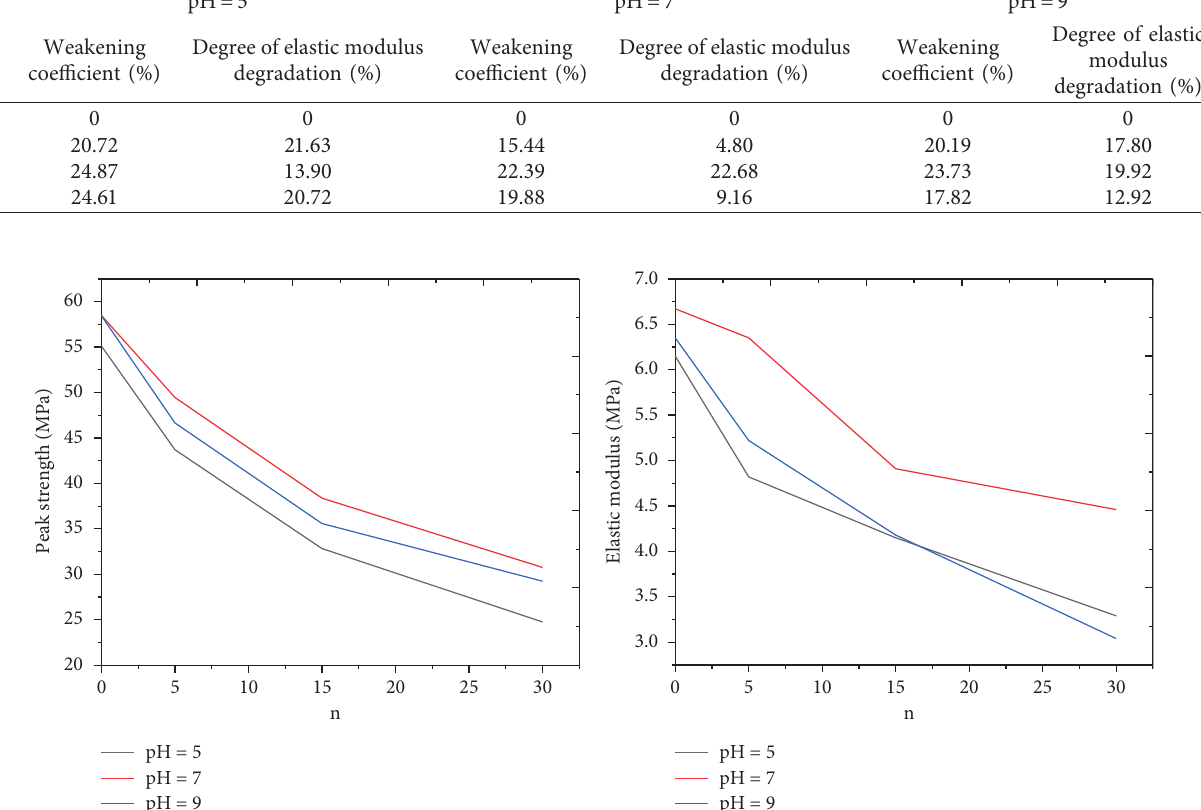
Figure 4: Change of mechanical parameters with the number of cycles.